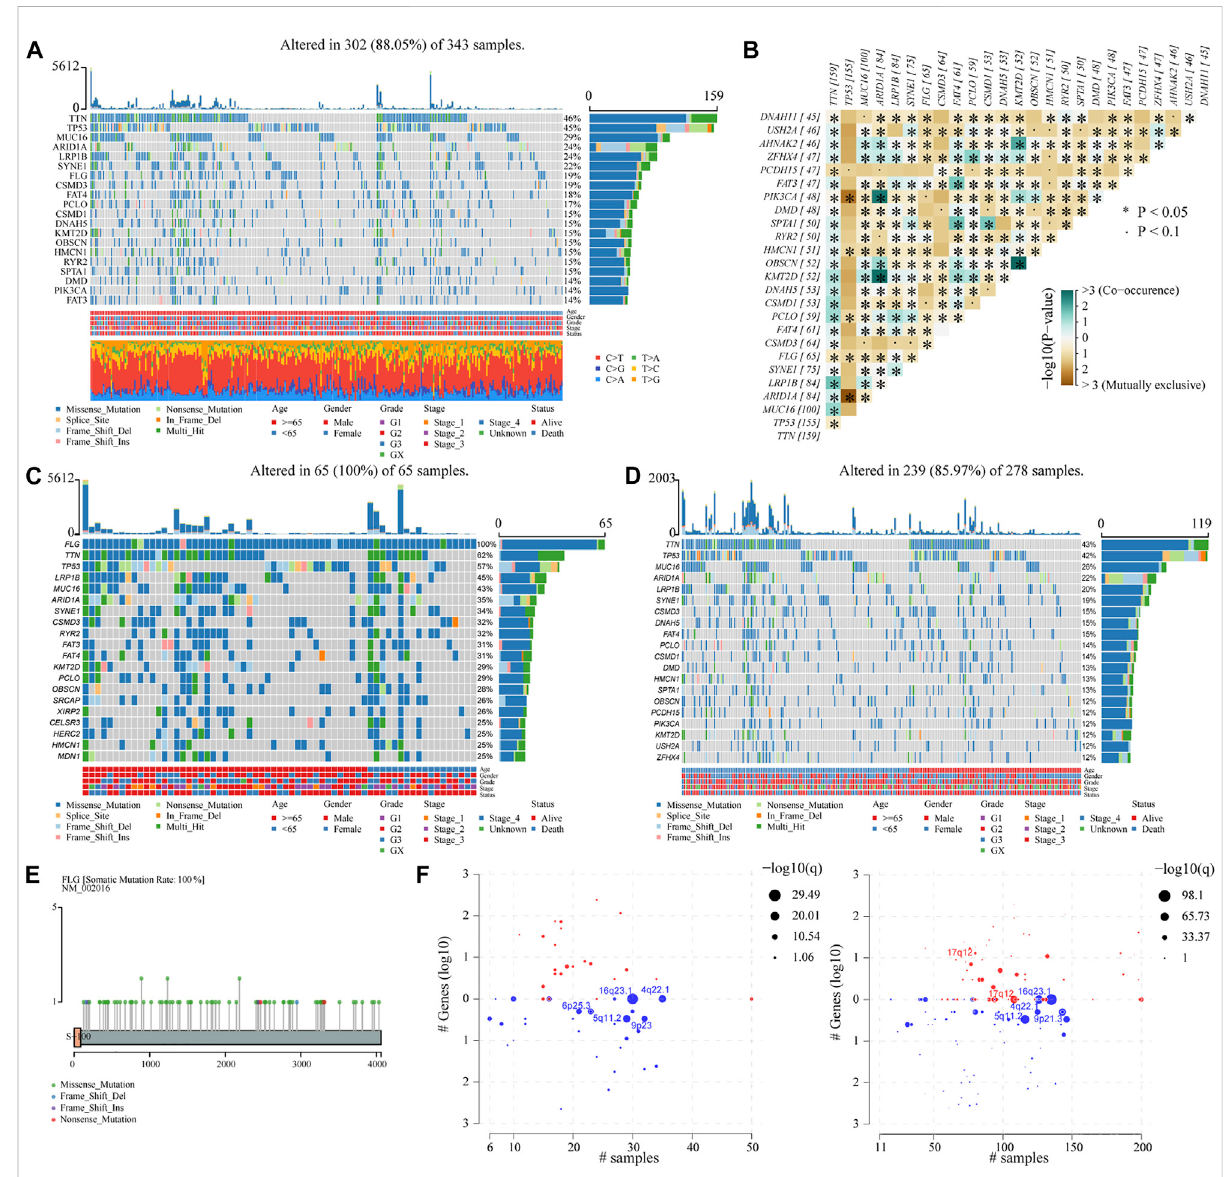
FIGURE 1 Correlation of clinical characteristics of STAD patients with FLG gene mutation. (A) Waterfall plot for all STAD patients in the study. Types of mutations were classi fi ed according to different categories, the majority of which were missense mutations. The C ＞ T mutation is the most common SNV. The corresponding TMB values of speci fi ctumor samplesand top 30ranked mutantgenes arealso shown. (B) Correlation analysisof different mutant genes. (C,D) Top 30 most frequently mutated genes in FLG -mutant and non-mutant groups. The left side is the FLG -mutant group, the right side is the non-mutant group. Genes are sorted by mutational frequency, and samples are sorted and ordered according to non- synonymousmutationalload.Thelegendearliershowsthemutationload.Age,gender,grade,stage,andOSstatusarenotedinorder. (E) Distribution diagram of amino acid variation of FLG proteins in the TCGA-STAD dataset, missense mutation is the main form. (F) TCGA-STAD samples with available CNV data were analyzed using GISTIC 2.0 software and visualized using Maftools